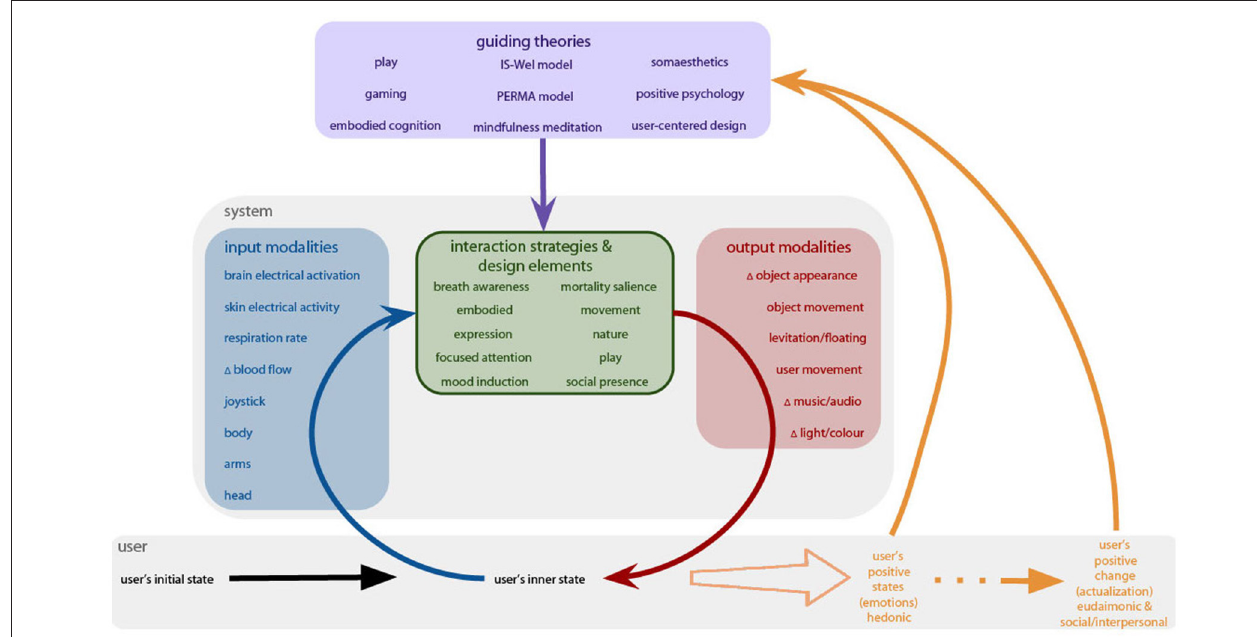
FIGURE 6 | A schematic of the framework for designing immersive, interactive experiences for eliciting positive states and supporting positive change.